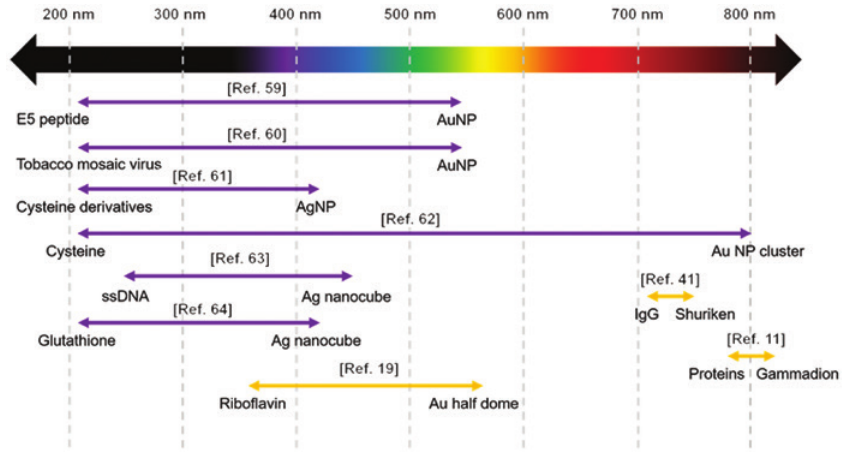
Figure 8: Comparison between molecular chiroptic signal bands and metamaterial working bands from the UV band to the NIR band. Left and right ends of each arrow correspond to the molecular chiroptical and metamaterial working bands, respectively, while the lengths of the arrows indicate the band mismatch between the two bands. Arrow colors indicate molecular chiroptical responses in the UV (purple), visible (orange), and NIR bands